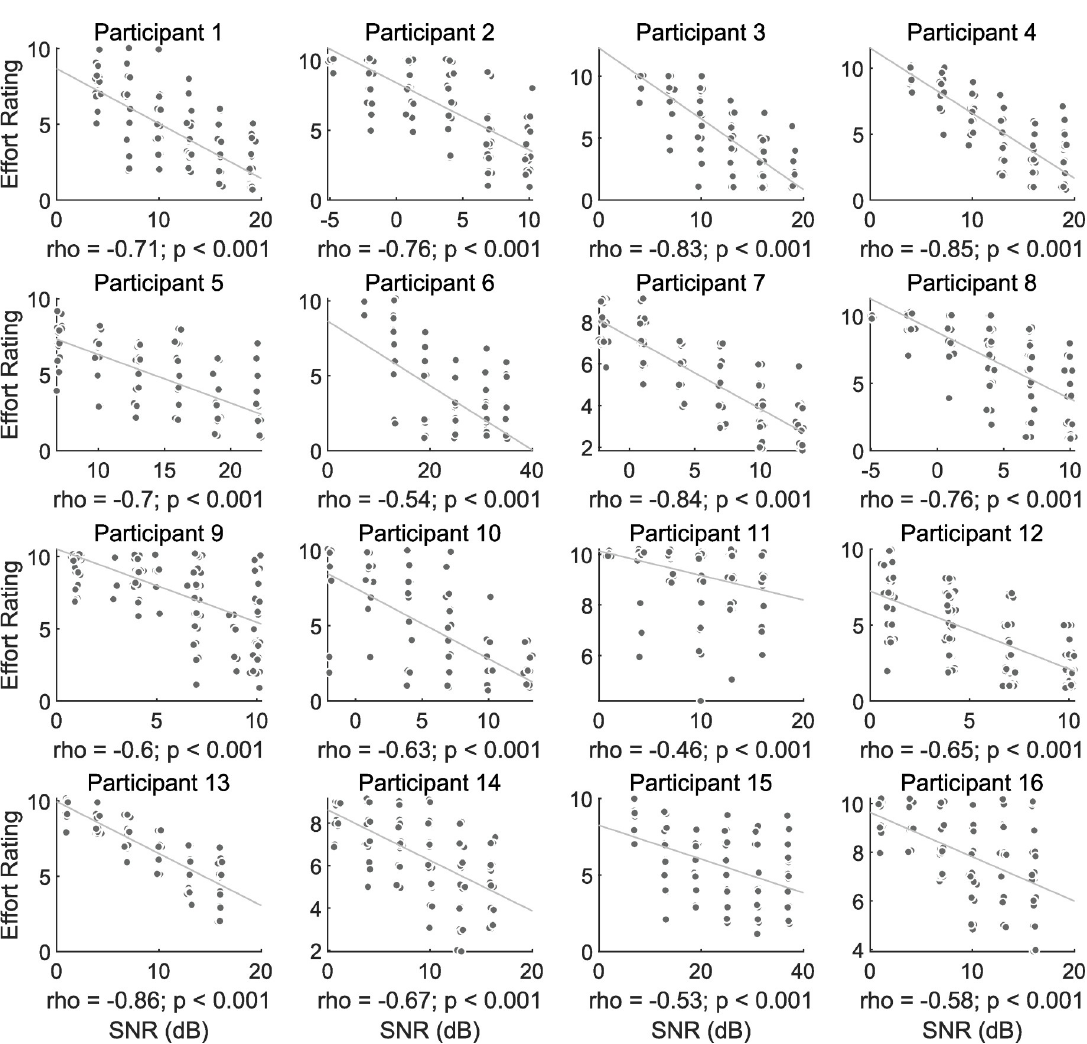
Fig 3. Single-subject effort–SNR correlations. Scatterplots for each participant showing the relationship between the trial SNR and effort ratings. Spearman’s rank correlation coefficients are provided below each plot with significance values. All lines represent the least squares fit. Correlations for all participants were significant, and survived false discovery rate correction. Note that values are jittered around each effort level and SNR level for visibility.